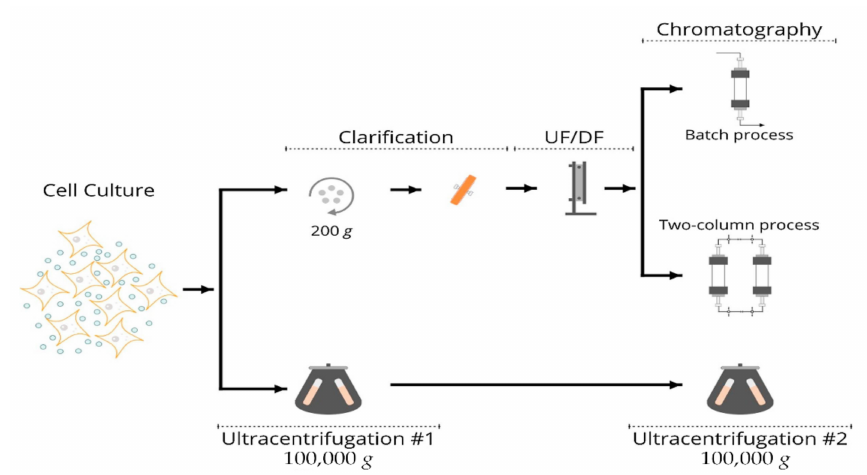
Figure 6. Workflow of the EV purification process. Purification method based on clarification (low- speed centrifugation and filtration), ultrafiltration, and size exclusion chromatography, which can be operated in batch or continuous mode (top route); isolation method based on two ultracentrifugation stages of 100,000 × g. Reprinted by permission from [50]. Copyright 2019